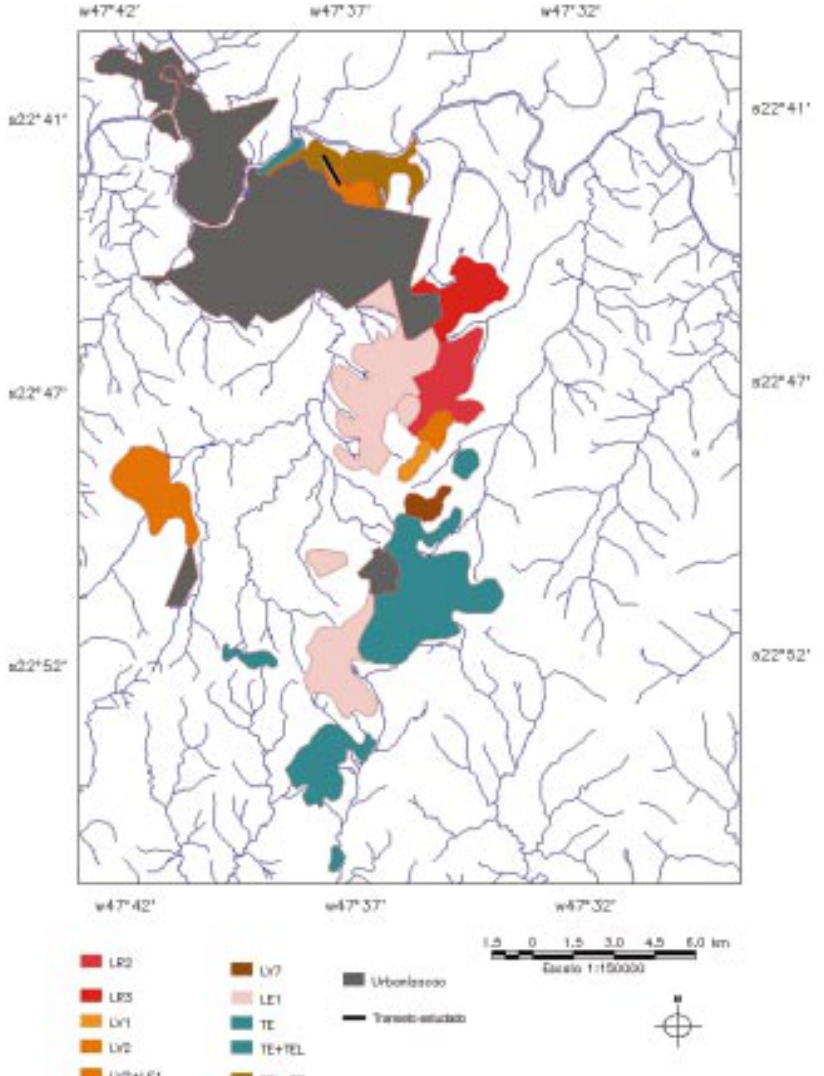
Figure 3. Map showing the Latossolos eutro- or distroférricos (Typic Hapludox) (LR2 and LR3) and Nitossolos vermelhos (Rhodic Kandiudalf) (TE, TE + TEL and TEL + TE) summits that would be vestiges of a tectonic barrier and their abrupt transition with sandy Latossolos Vermelhos-Amarelos (Typic Hapludox) (LV1, LV2, LV2 + LE1 and LV7) and sandy Latossolos Vermelhos (Typic Hapludox) (LE1) which would be the sandy deposits stopped by the tectonic